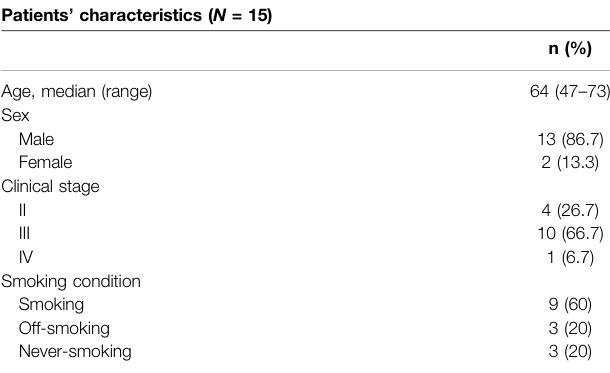
TABLE 1 | Clinical characteristics of NSCLC patients. Patients ’ characteristics ( N =